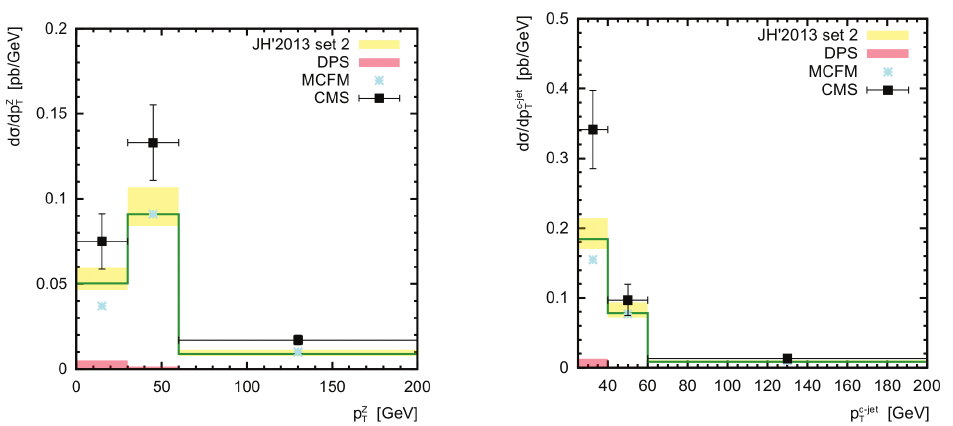
Figure 6. The associated Z + c production calculated as a function of Z boson and c -jet transverse momenta at √ s = 8 TeV. Notation of histograms is the same as in Fig. 1. The experimental data are from CMS [1].